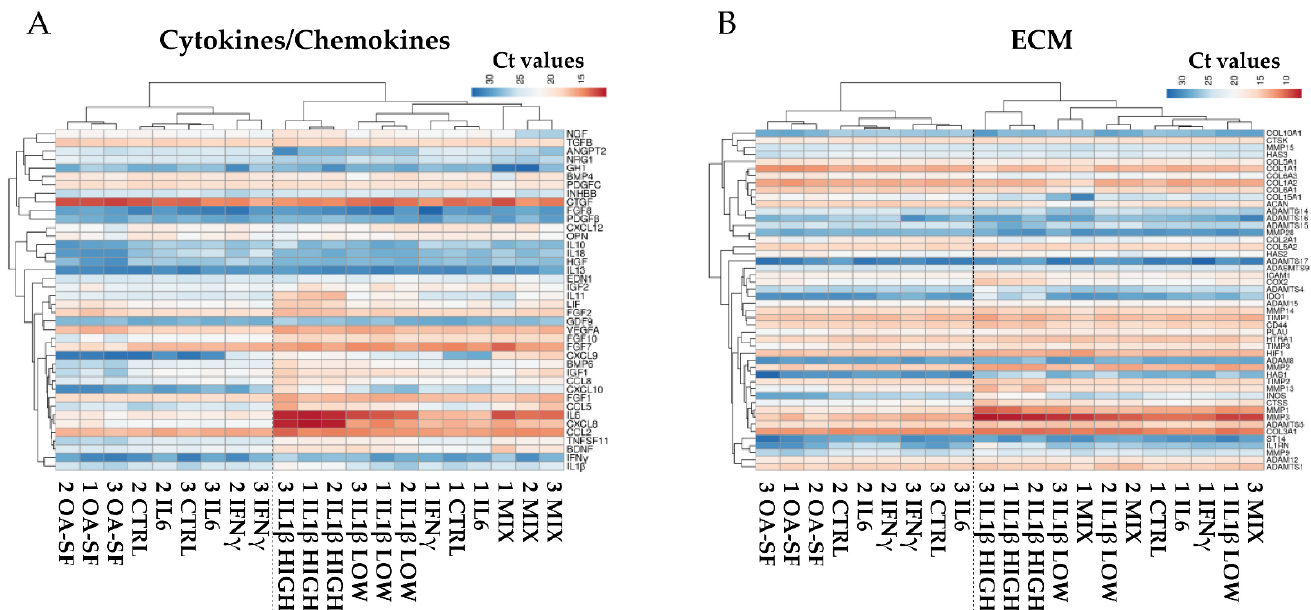
Figure 3. Heatmap showing differential expression of either cytokine/chemokine ( A ) or ECM ( B ) related genes between control (CTRL) and stress treatments (abbreviations as in Figure 2) in the three HCH donors. Red shades indicate higher expression and blue shades indicate lower expres- sion. Color key indicates the intensity associated with normalized C t values.